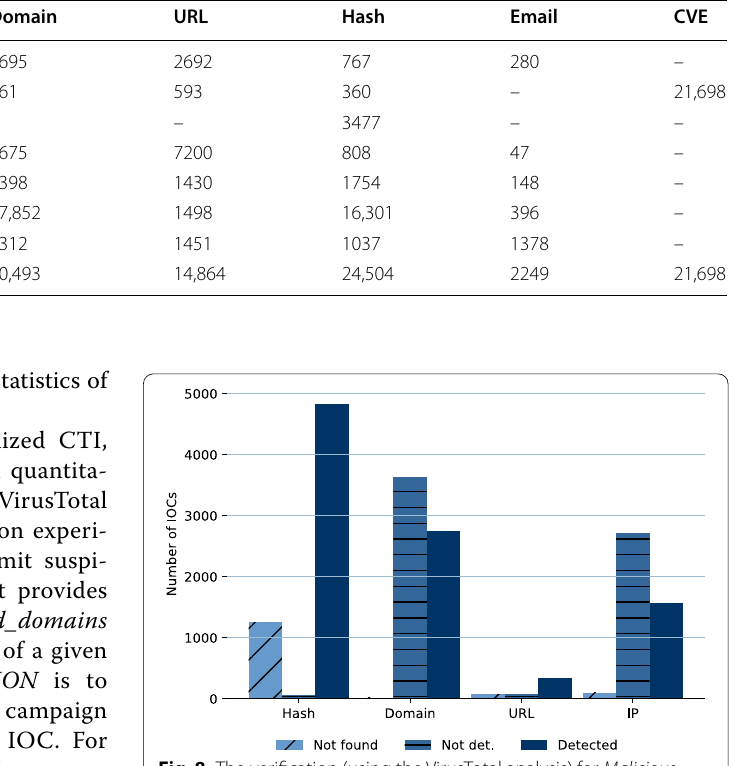
Fig. 8 The verification (using the VirusTotal analysis) for Malicious IOCs discovered from TriCTI. Note: Not found is a fraction of IOCs that are not found in VT, Not det. indicates that the IOCs are found in VT but none of the antivirus scanners mark it as malicious, and Detected represents the number of the IOCs that are found in VT and are labeled malicious by at least one antivirus